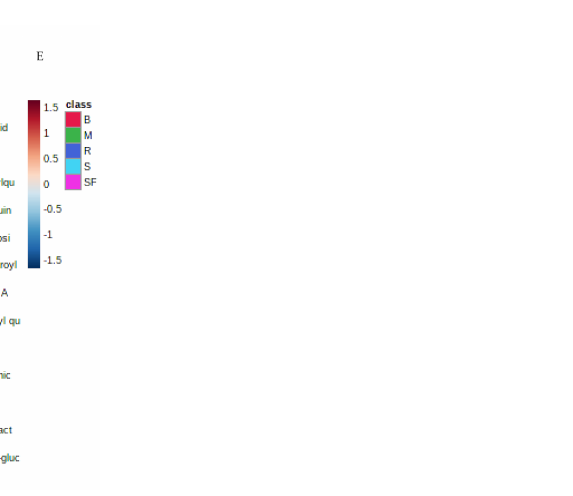
Figure 1. Statistical analyses of bioactive metabolites by Metaboanalyst 4.0 software. ( A ) Unsuper- vised PCA score plot of phenolic compounds of Momordica balsamina leaves generated by UPLC- QTOF/MS analysis showing the separation of five clusters. R: raw leaves; M: microwaved leaves; S: streamed leaves; B: boiled leaves; SF: stir-fried leaves. ( B ) The PC 1 and PC2 loadings of bioactive metabolites. ( C ) Supervised PLS-DA score plot of bioactive metabolites. ( D ) VIP scores of bioactive metabolites in PLS-DA. ( E ) Heat map. The colored areas on the map correspond to concentrations of different bioactive metabolites. Bioactive metabolites are arranged in rows, and different household cooking techniques are in columns. The red color indicates high levels, and the blue color indicates low